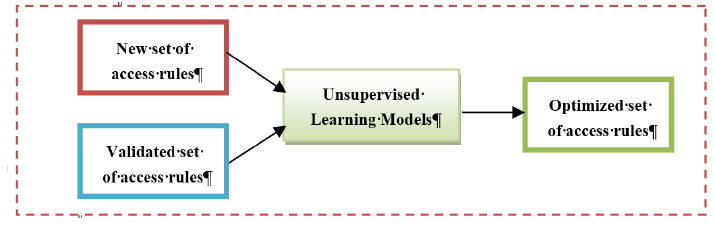
Fig. 4. Inputs and Outputs of Unsupervised Learning